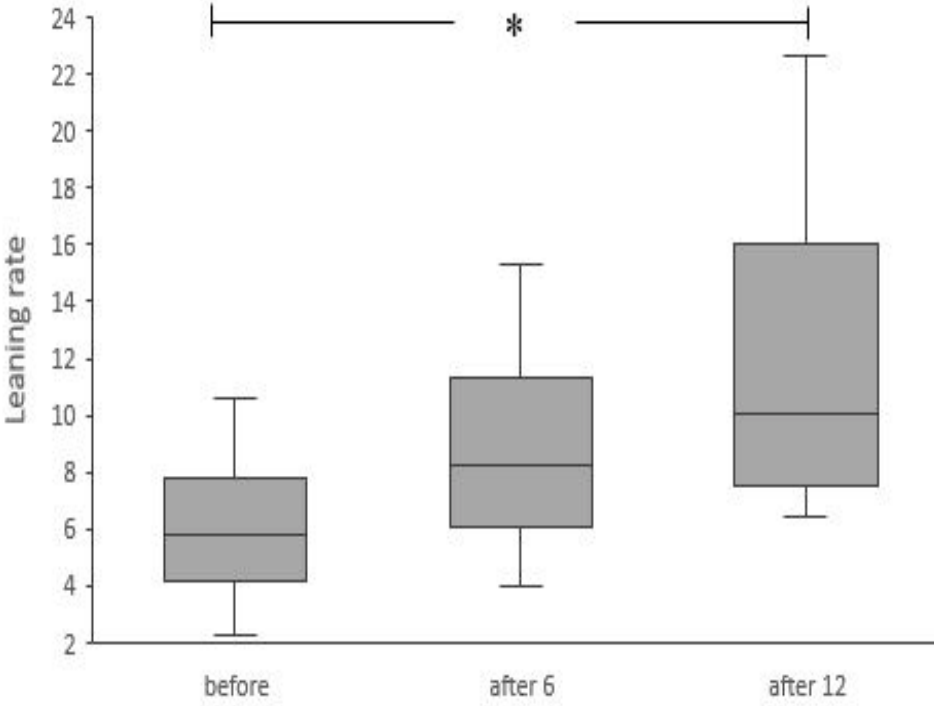
Figure 6. Results for the leaning rate (linear regression coefficient of the second phase of limit of stability test), which defines the speed of forward leaning movement, before intervention, after six and 12 training sessions. * Significant differences ( p < 0.05). Box plots indicate interquartile ranges (areas within a box), medians (horizontal line in the box), and error bars indicate the range (min–max).